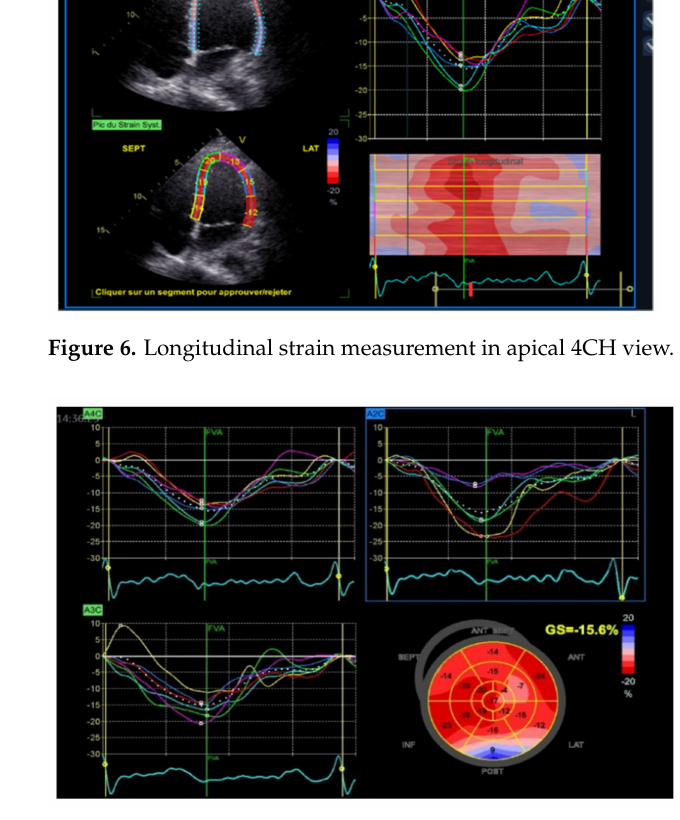
Figure 7. Strain curves from apical 4CH, 3CH, 2CH to calculate global longitudinal strain